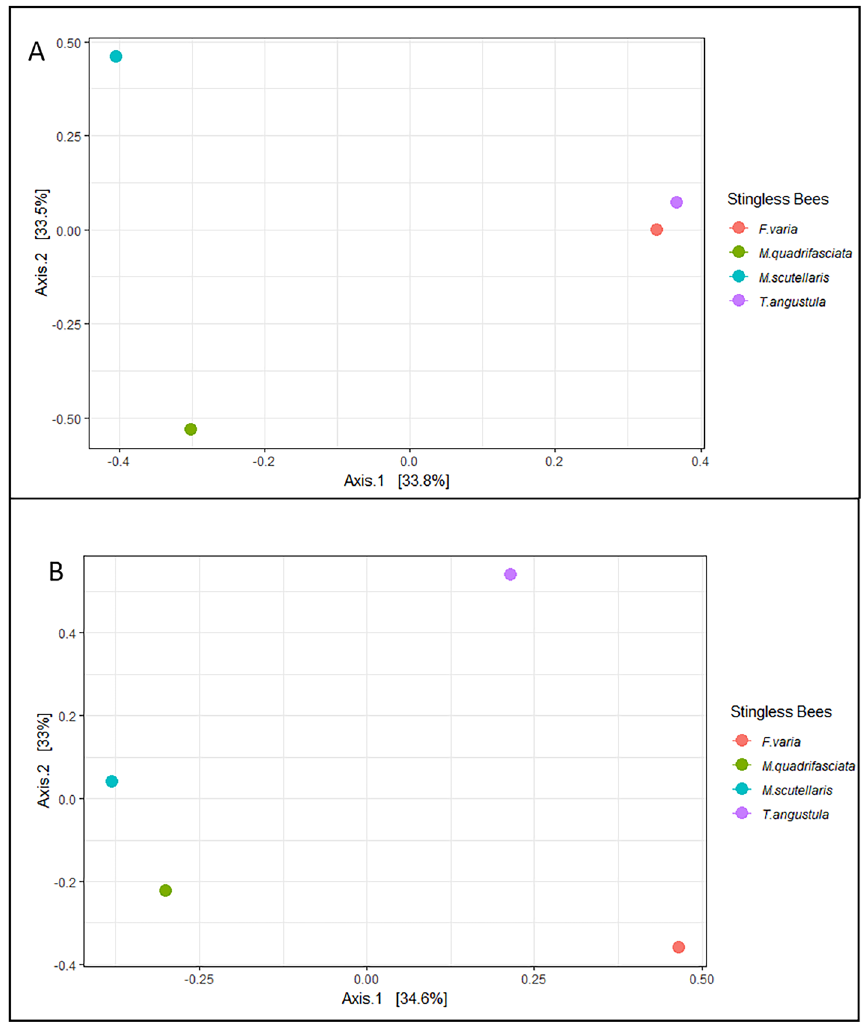
Figure 4. PCoA analysis Bacterial ( A ) and Fungal ( B ) community sequencing.